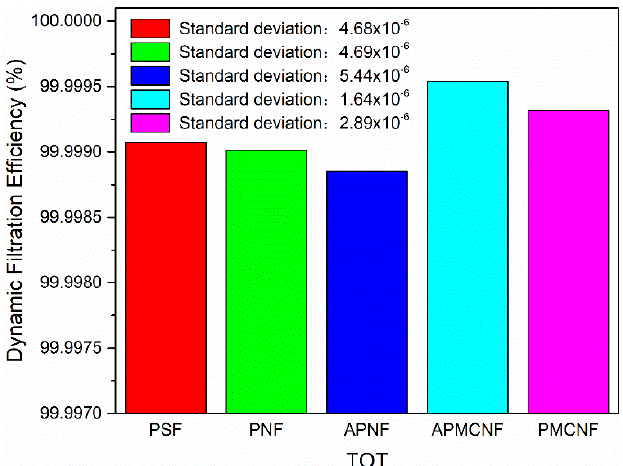
Figure 16. The dynamic filtration efficiencies of the five filter media for TOT during the performance test period.